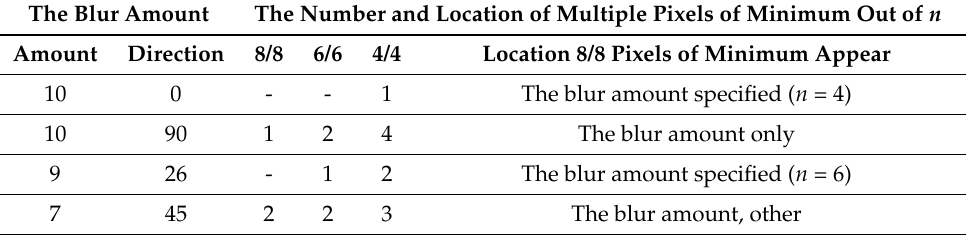
The blur amount, other